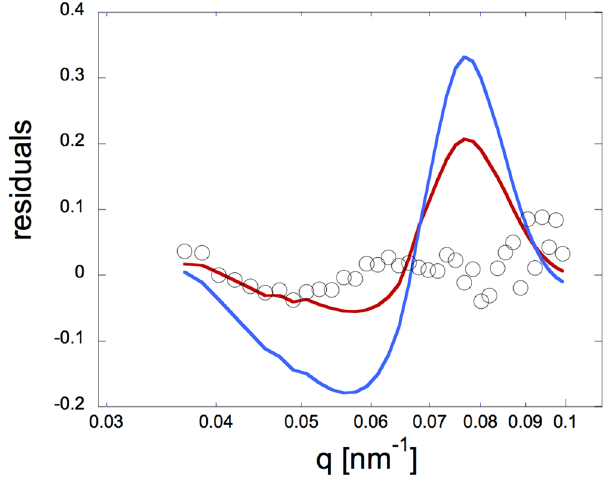
Figure 5. Assessing the sensitivity of the SANS analysis. Comparison of the concentration-normalized scattered SANS intensity I ( q )/ C , where C is the weight concentration, in ZAC contrast from samples with an effective volume fraction φ eff = 0.67 and φ eff = 1.0 in a residual plot [ I ( φ eff = 1.0)/ C − I ( φ eff = 0.67)/ C ]/ I ( φ eff = 0.67/ C ). Also shown are calculated form factors for different values of the effective polydispersity also as residual plots